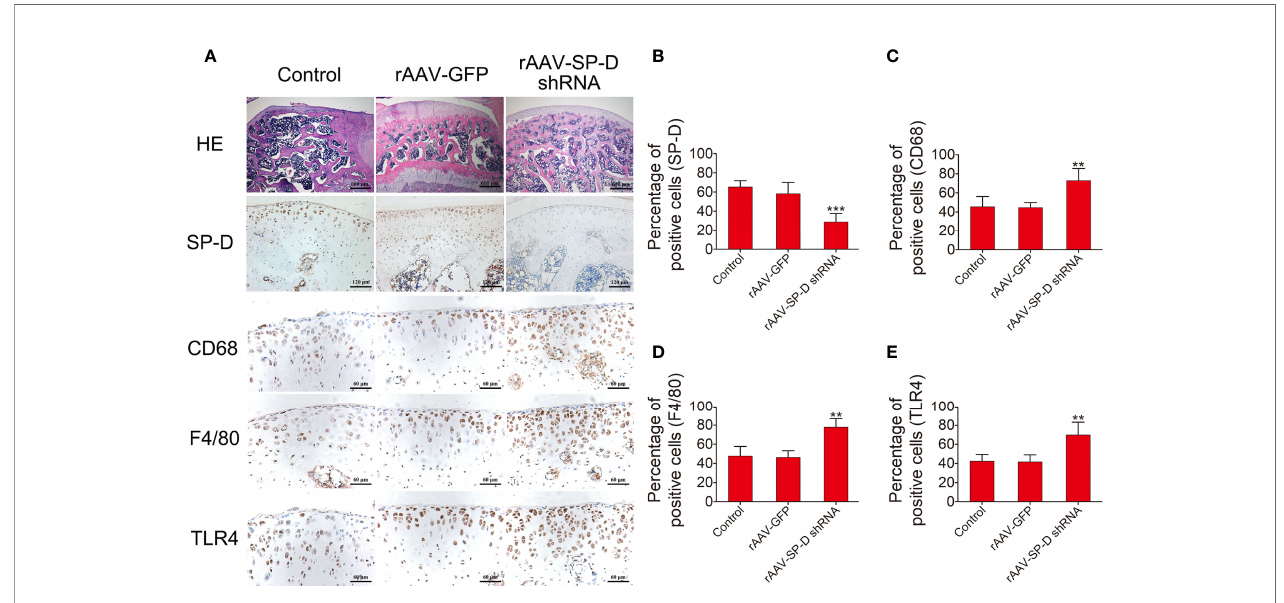
FIGURE 2 | RAAV-mediated SP-D gene was transferred into the rat knee joints. (A) Rats were injected intra-articularly with rAAV encoding SP-D-speci fi c shRNA for 10 consecutive days and sacri fi ced at the fourth week of the fi rst injection. H&E staining and immunohistochemical staining of SP-D, CD68, F4/80, and TLR4 protein levels in cartilage were assessed following rAAV-GFP or rAAV-SP-D shRNA injection into the rat knee joints. The ratios of immunoreactive cells of SP-D (B) , CD68 (C) , F4/80 (D) , and TLR4 (E) were analyzed. Data were expressed as mean ± SEM (n = 5). **P < 0.01 and ***P < 0.001 vs. rAAV-GFP